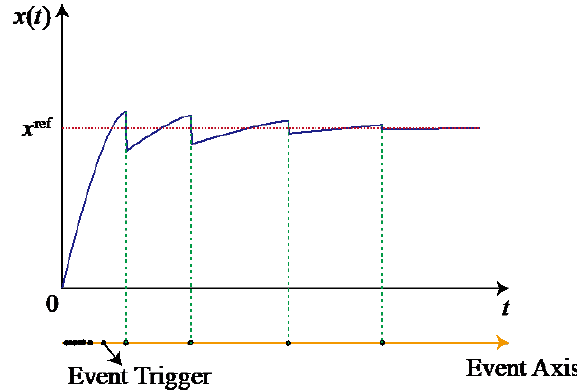
Figure 6. Regulation pattern with event-triggered mechanism.